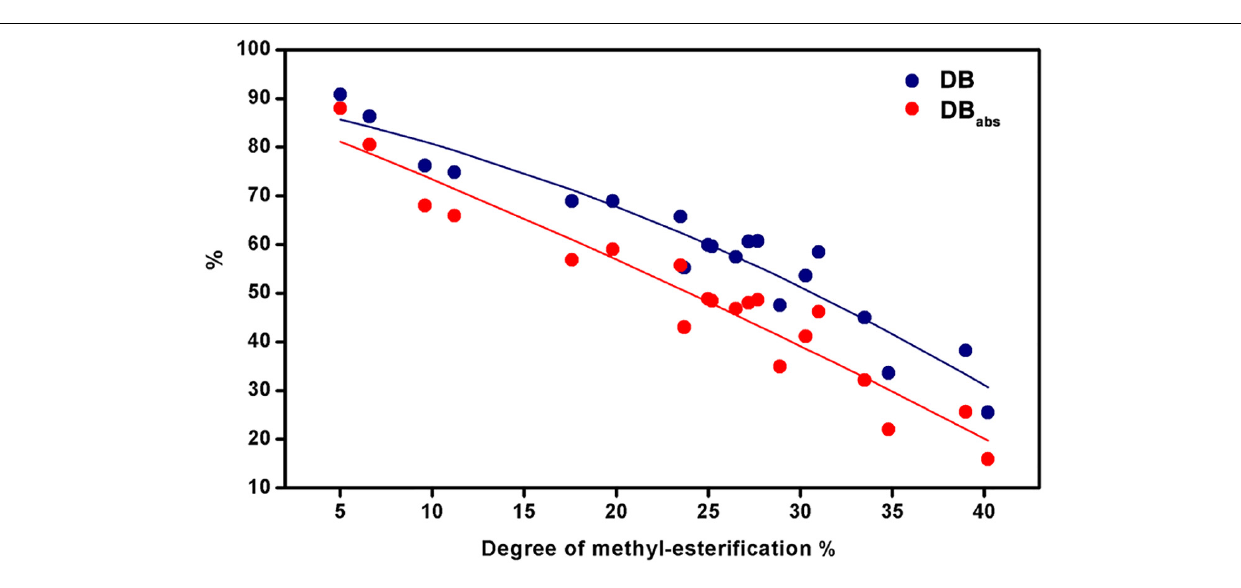
features, including methyl-esterification distribution